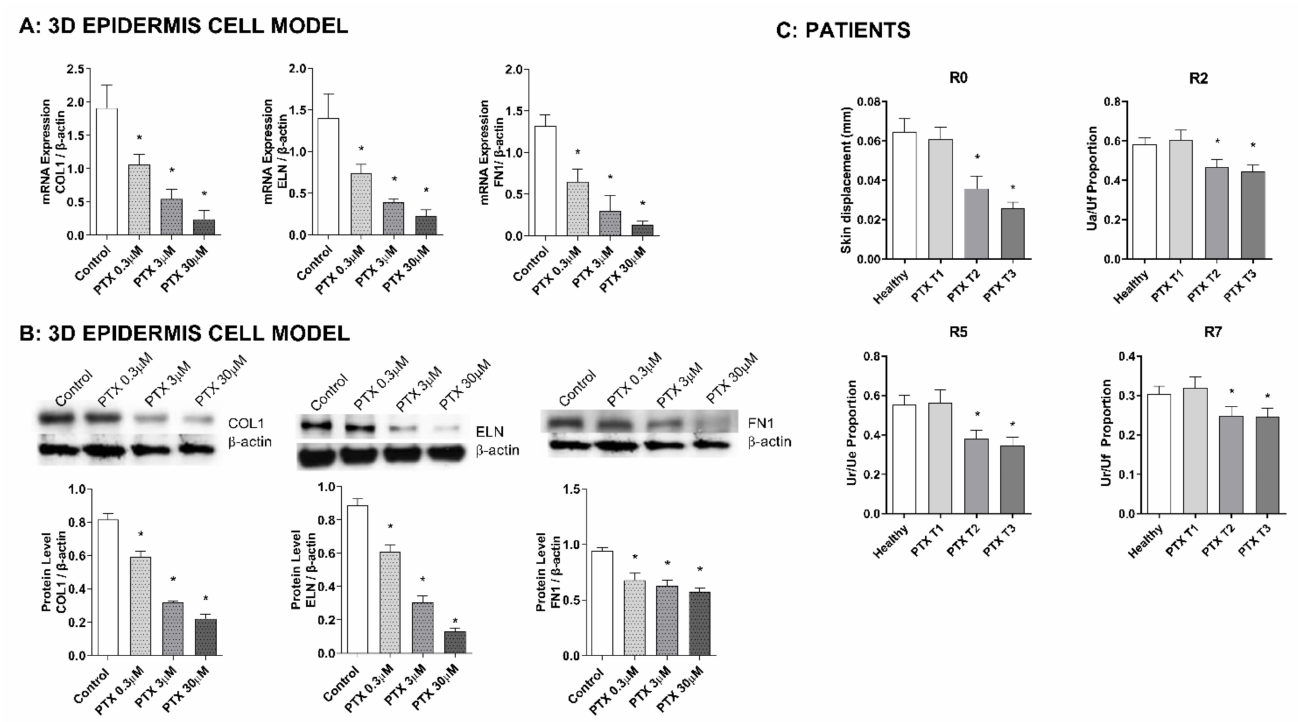
Figure 2. Paclitaxel impairs skin elasticity and firmness in oncologic patients and reduces the expression of elasticity and firmness molecular markers in a 3D epidermis model. ( A ) The 3D epidermis models were incubated for 24 h with increasing paclitaxel (PTX) concentrations. Collagen type 1 (COL1), elastin (ELN), and fibronectin (FN1) mRNA levels were measured by real-time PCR. Data are expressed as 2 − ∆ Ct . ( B ) The 3D epidermis models were incubated for 24 h with increasing PTX concentrations. COL1, ELN, and FN1 protein levels were analyzed by Western blotting. Quantification was performed by densitometry and normalized to β -actin. Results are expressed as the mean ± standard deviation of two independent experiments ( n = 3); * p < 0.05 vs. control. Uncropped Western Blots can be found at Supplementary File. ( C ) The elasticity and firmness parameters R9, R2, R5, and R7 were measured in 20 oncologic patients before (T1), during (T2), and after (T3) treatment with PTX, and in 20 healthy subjects as a control group. Measurements were conducted with Cutometer ® MPA 580 probe in the cheekbone. Results are expressed as the mean ± standard deviation of at least 3 measurements each time ( n = 20); * p < 0.05 vs.